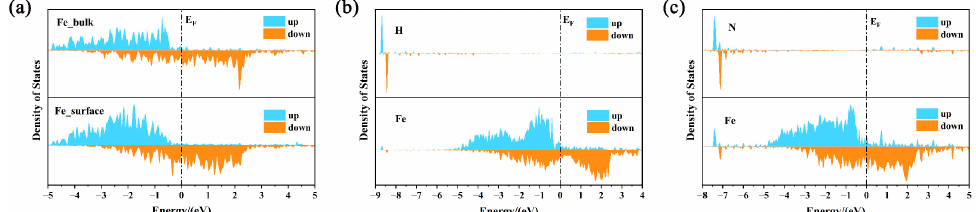
Figure 2. DOS of pure γ -Fe and H/N-containing austenite. ( a – c ) are the DOS of pure γ -Fe and H/N-containing austenite, respectively.